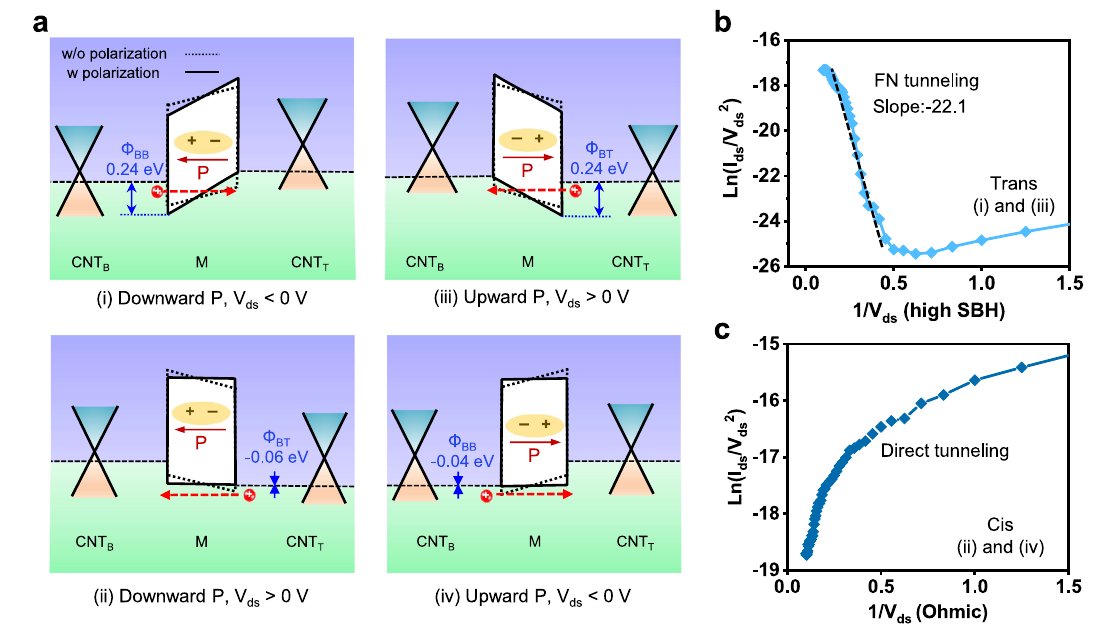
vs. 1 /V curve in the (i, iii) and (ii, iv) regimes regarding the trans and cis states,